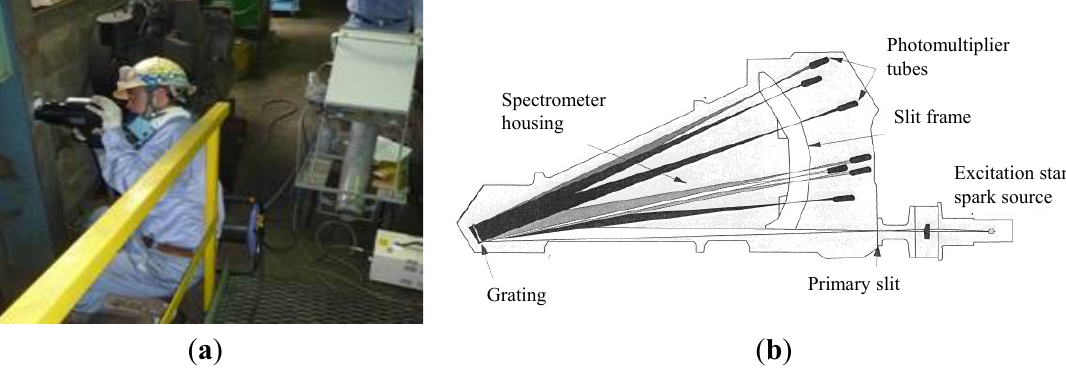
Figure 6. ( a ) Portable optical emission spectrometer and ( b ) the principle of portable optical emission